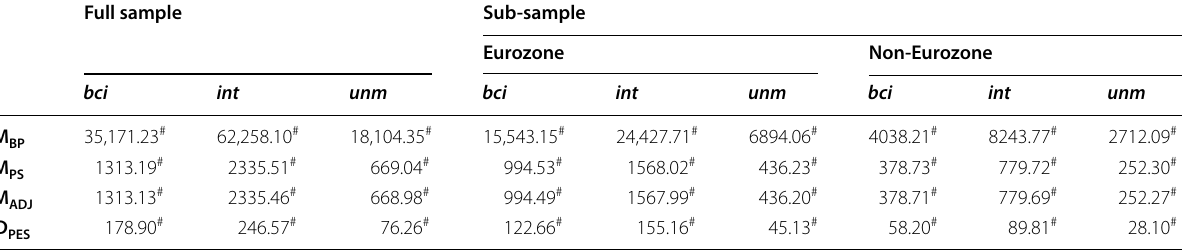
Table 2 Cross-sectional dependence tests results